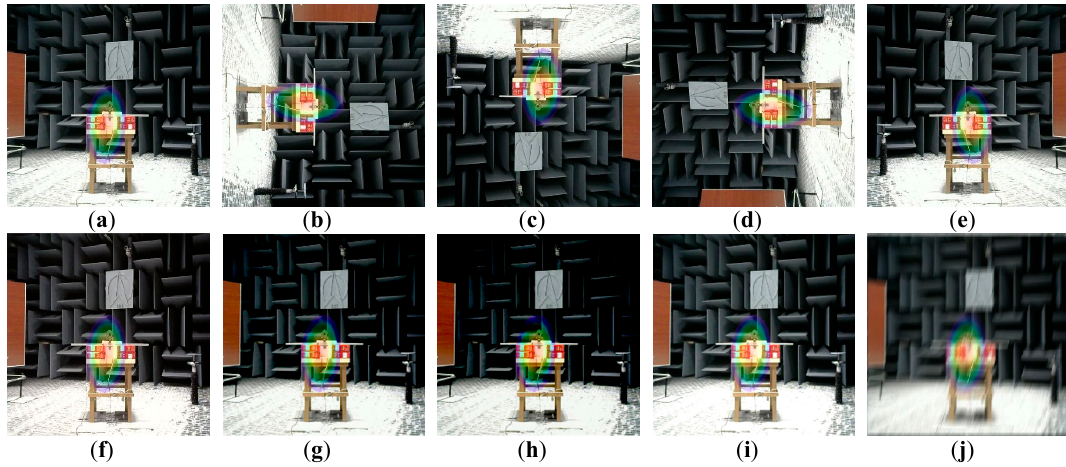
Figure 9. Data set image augmentation: Image augmentation methods: ( a ) original image, ( b ) 90° clockwise rotation, ( c ) 180° clockwise rotation, ( d ) 270° clockwise rotation, ( e ) horizontal mirror, ( f ) color balance processing, ( g – i ) brightness transformation, and ( j ) blur processing.